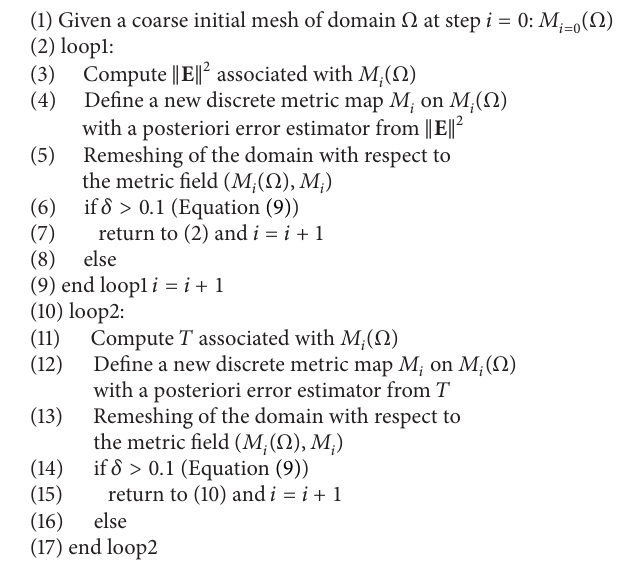
Algorithm 1: Algorithm of sequential adaptive remeshing strategy 𝐴 1 .